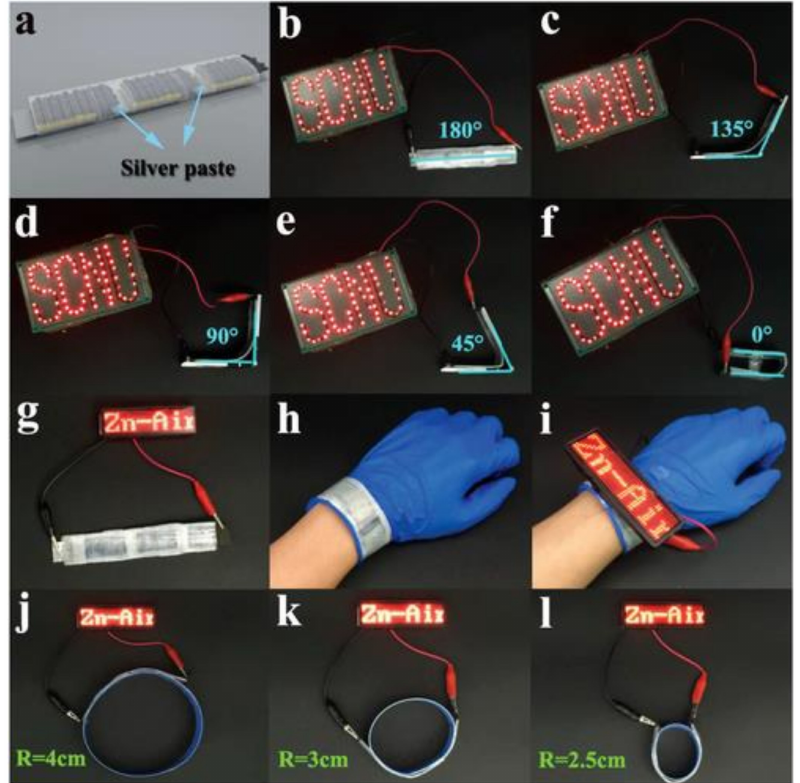
Figure 3. Digital photos of ( a ) a flexible solid-state zinc–air battery (ZAB) with three modules in series; ( b – f ) 75 red LEDs with “SCNU” shape powered by the ZAB of the panel ( a ) under bending angles of 180 ◦ , 135 ◦ , 90 ◦ , 45 ◦ , and 0 ◦ , respectively; ( g – l ) ZAB under bending angles of 0 ◦ powering a 3V LED breastpiece, ZAB as a wearable bracelet, ZAB powering a 3V LED breastpiece at di ff erent bending radii of 4, 3, and 2.5 cm, respectively. Reproduced from reference [96] under CC BY 4.0